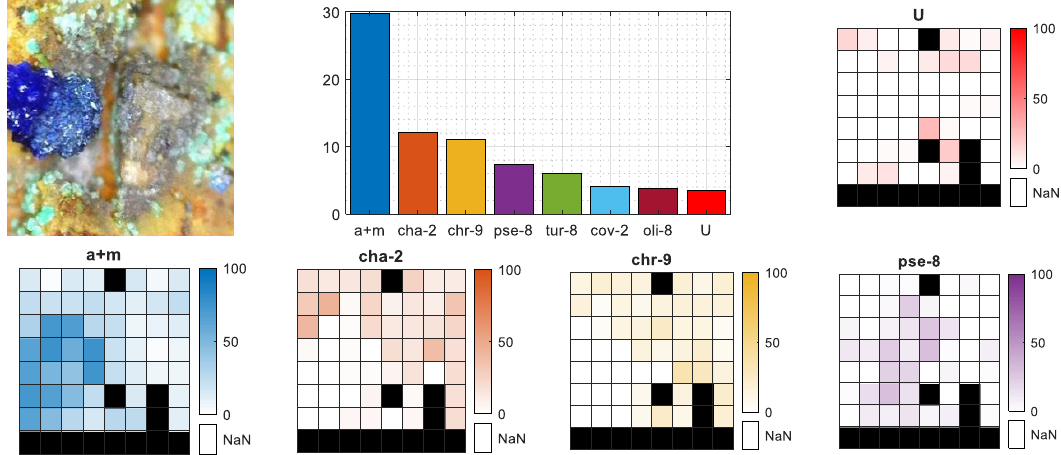
Figure 9. Mineral contribution for selected MP of azurite sample. Bar chart presents the total percentage rate of minerals per MP, the image indicates the place of measurement on the sample surface and the heatmaps present the geometrical distribution of the four main minerals and unknown class within 8 × 8 shooting grid. Black fields are missing spectra.